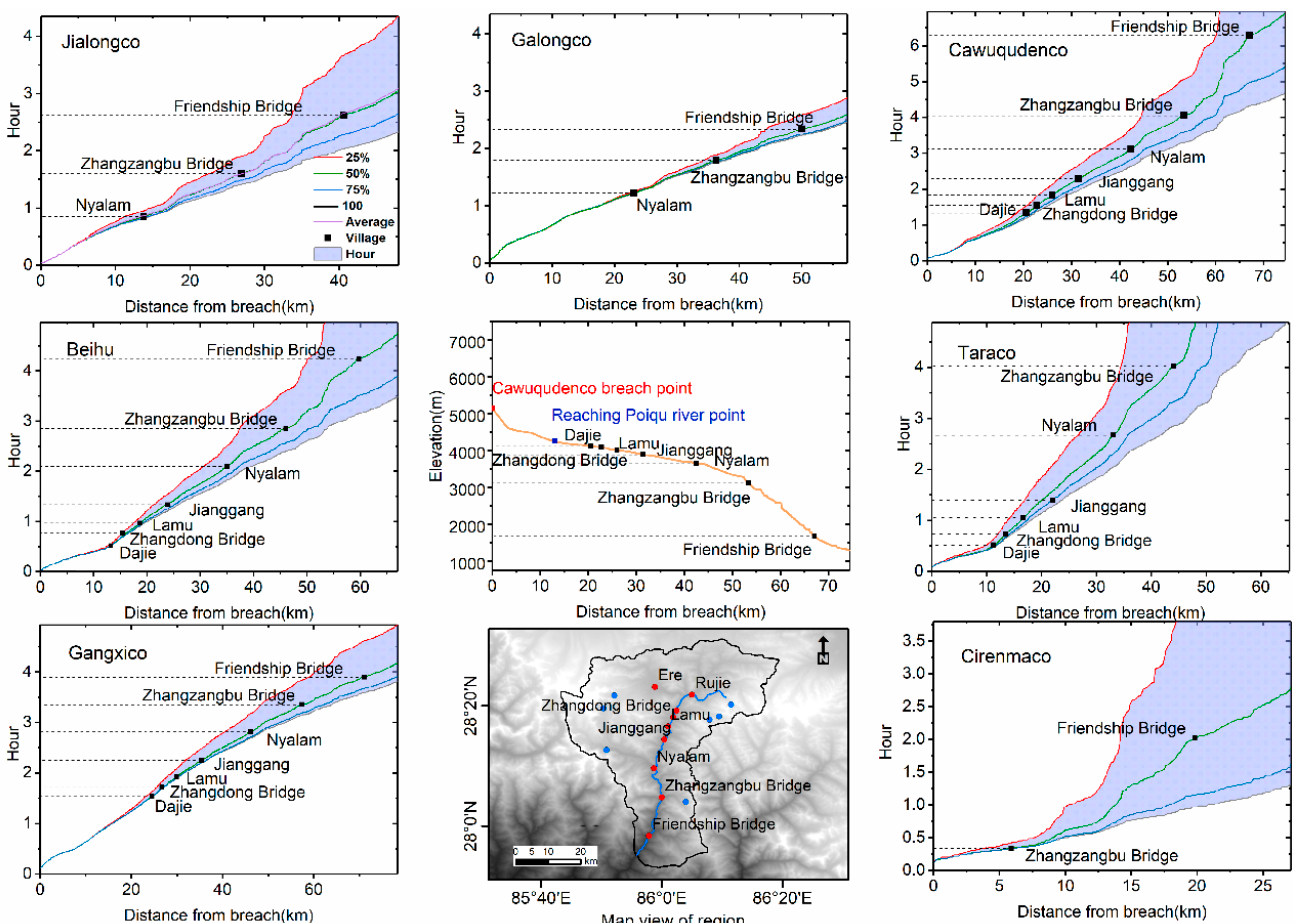
Figure 6. Arrival time of peak discharge for various villages and